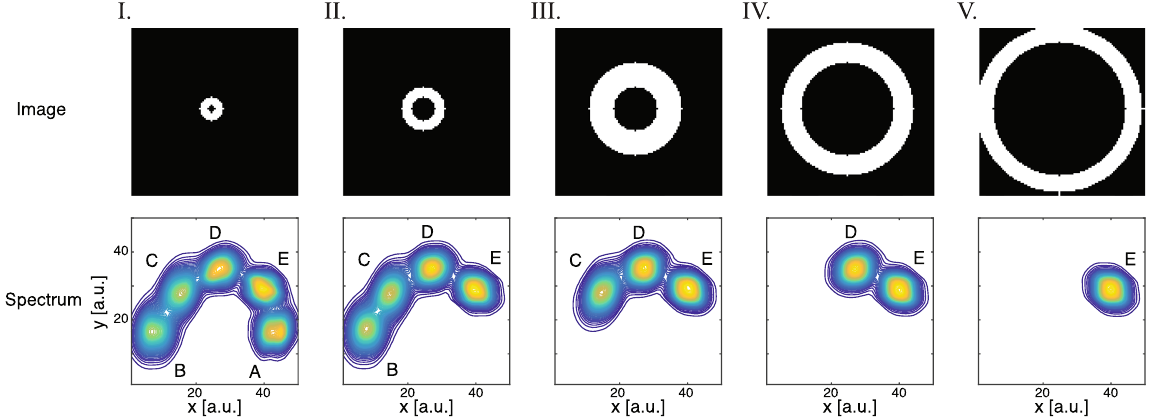
Figure 2. The simulations model. Each column shows a different simulated image-spectrum pair. Pixels in the inner most ring (I) contain all 5 spectral components ( A – E ), while pixels in the outer most ring (V) contain only a single spectral component ( E ). The synthetic phantom was created by superimposing all 5 image- spectrum